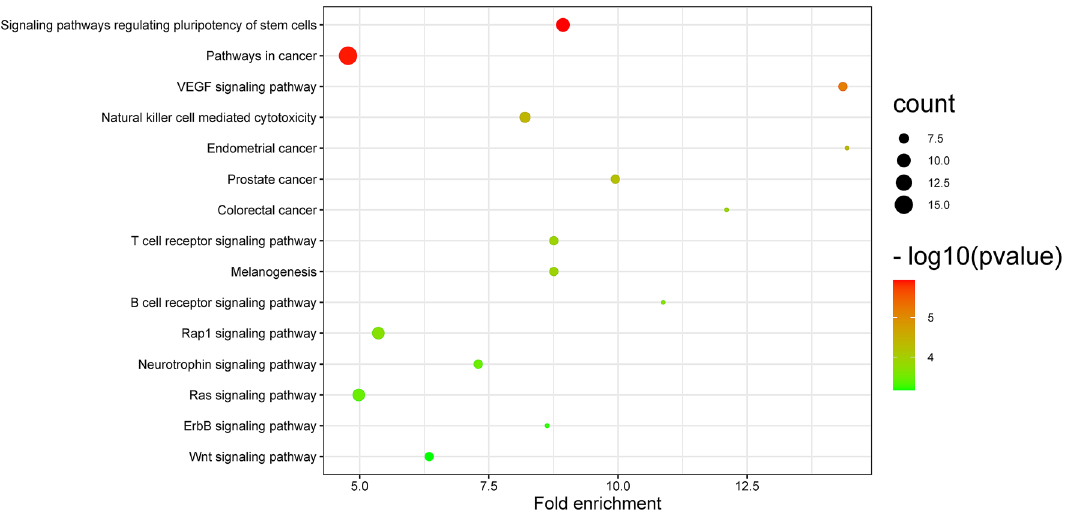
Figure 4. The top 15 signaling pathways with the highest enrichment ratio. The size of the circle represents the number of enriched target proteins. The p value represents the significant degree of enrichment of the target protein.